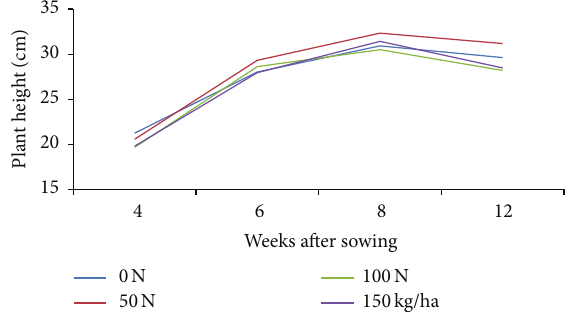
Figure 6: Significant ( 𝑝 < 0.05 ) growth trend of garlic response to different nitrogen rates at 4, 6, 8, and 10 weeks after sowing on plant height during the period of the experiment.